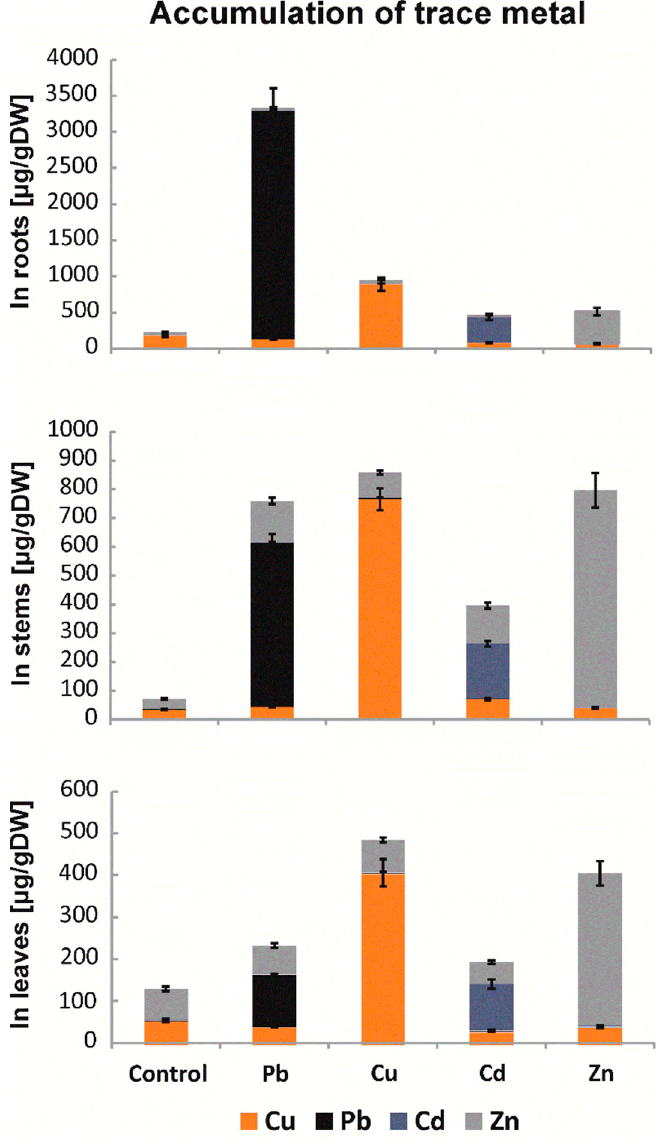
Figure 1. Accumulation of Pb, Cu, Cd, and Zn in the roots, stems, and leaves of B. juncea var. Malopolska seedlings grown in Hoagland’s medium and treated with lead, cooper, cadmium, and zinc ions. Metal solutions Pb(NO 3 ) 2 , CuSO 4 , CdCl 2 , and ZnSO 4 were applied at a 50 µ M concentration. Mean values of three replicates (±SD).